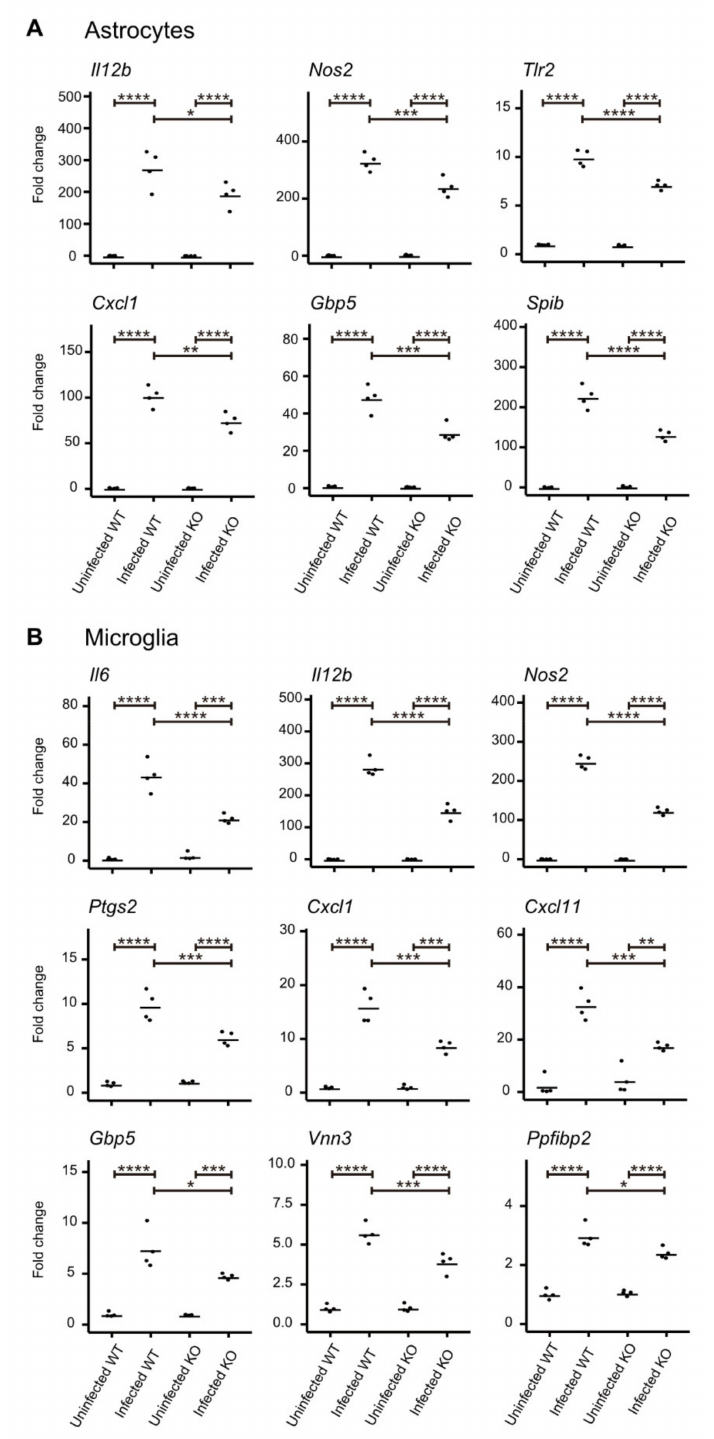
Figure 4. Expression patterns of DEGs in primary astrocytes and microglia during T. gondii infection. Primary astrocytes ( A ) and microglia ( B ) were infected with T. gondii tachyzoites for 24 h at a MOI of 1.0. Genes with a significant interaction between genotype and infection ( p < 0.05, two-way ANOVA) are shown. Horizontal bars represent the mean values of four replicate samples in each group. * p < 0.05, ** p < 0.01, *** p < 0.001, **** p < 0.0001 (two-way ANOVA with post-hoc Tukey’s